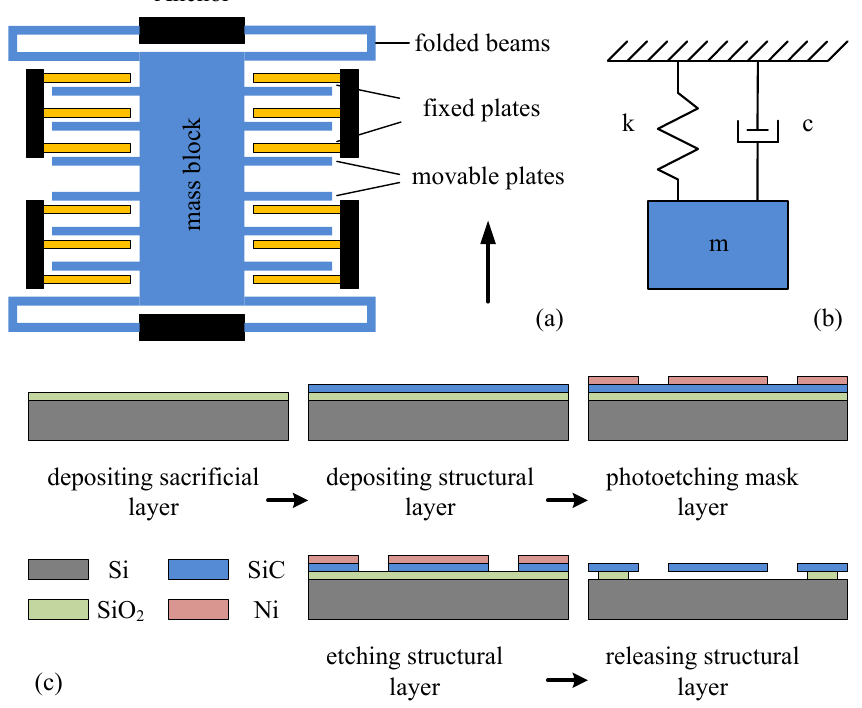
Figure 1. Model of a single-axis, comb-type capacitive micro-accelerometer. ( a ) Physical model of the accelerometer, ( b ) mechanical model of the accelerometer, and ( c ) process flow of the accelerometer [21].